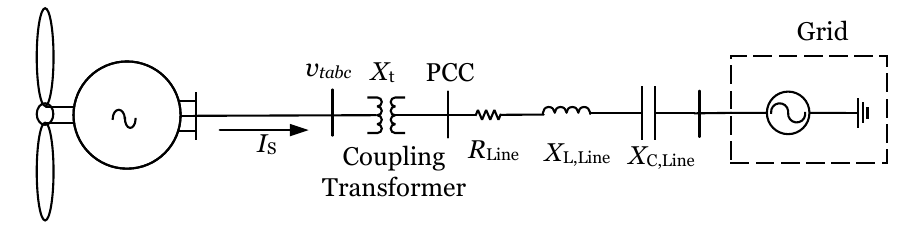
Figure 1. Schematic diagram of a Type I wind